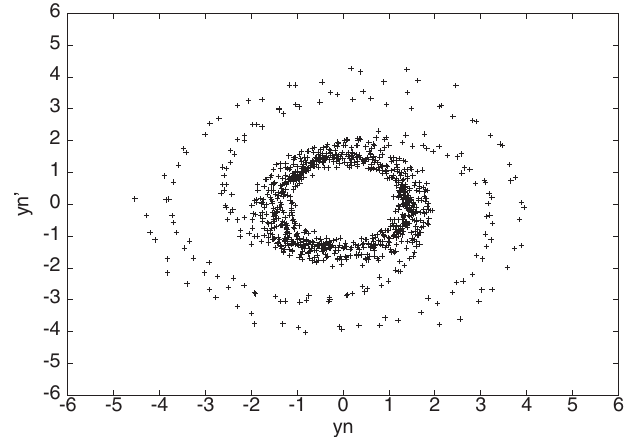
FIG. 22. Normalized vertical phase space after compensation.